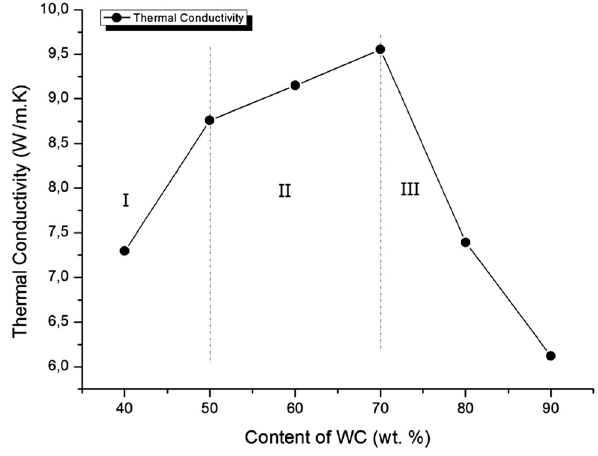
Figure 6: Variations of thermal conductivity with the composition of WC for WC – Co – Ni – Cr composites.